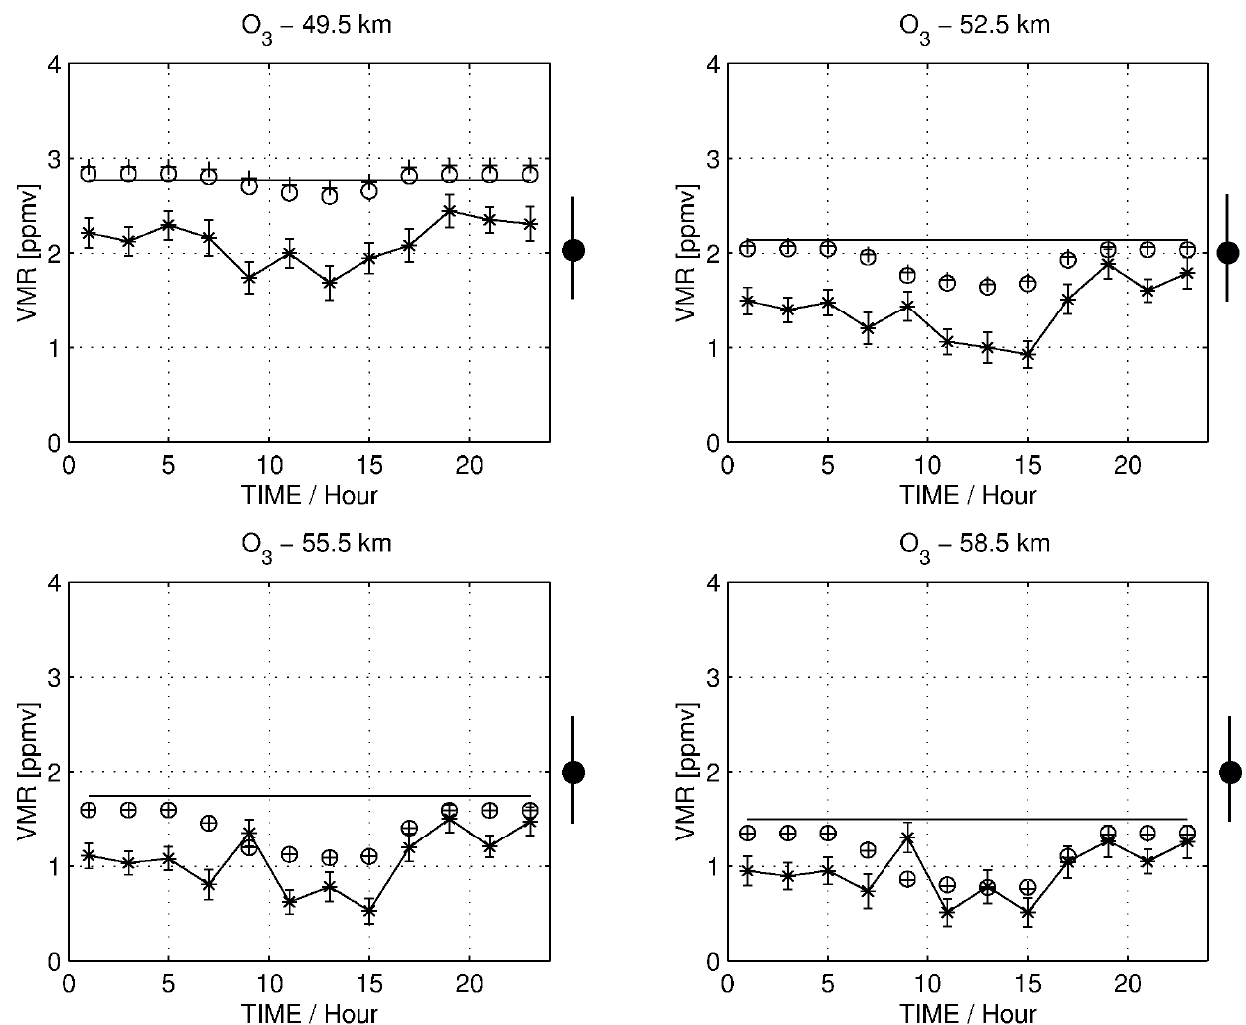
Fig. 14. Measured diurnal variations of O 3 (stars) at 49.5, 52.5, 55.5 and 58.5 km, together with the a priori value (solid line), and calculations from the 0-D model: run A (crosses) and run B (open circles). Only an uncorrelated 1- σ error due to the thermal noise is considered in the errorbar. Systematic 1- σ error for the Bure measurements (filled circle and thick line) is represented on the right-hand side of each